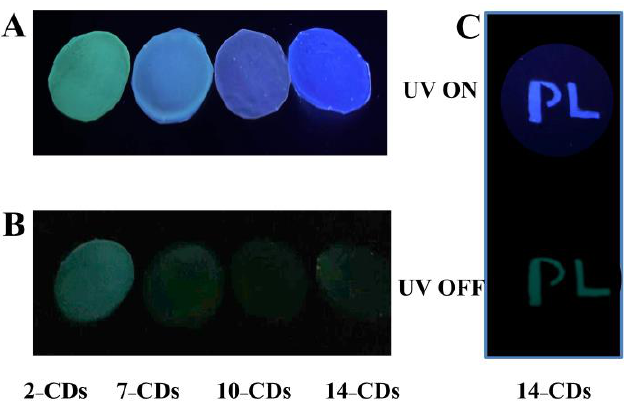
Figure 7. ( A ) Fluorescence and ( B ) Phosphorescence photos of 2–CDs − PVA, 7–CDs − PVA, 10–CDs- PVA and 14–CDs − PVA film, ( C ) 14–CDs − PVA film anti-counterfeiting application.